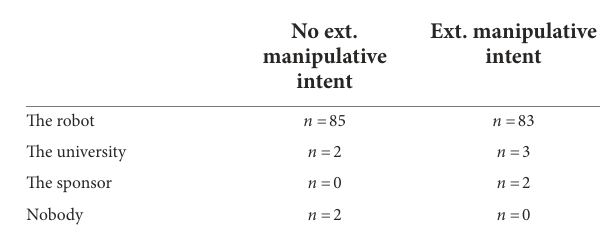
TABLE 6 Distribution of given answers for the question who decided which voucher will be presented. Question 3: “… made the decision which vouchers were presented to me.”